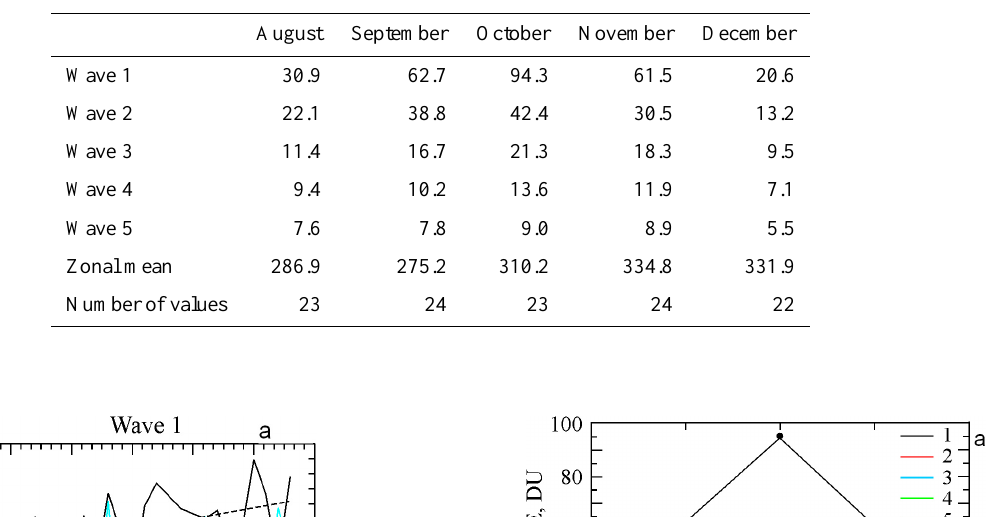
Table 1. The values of the monthly mean amplitude of the wave numbers 1–5 and zonal mean total ozone at 65 ◦ S (in Dobson Units), averaged for 1979–2003.